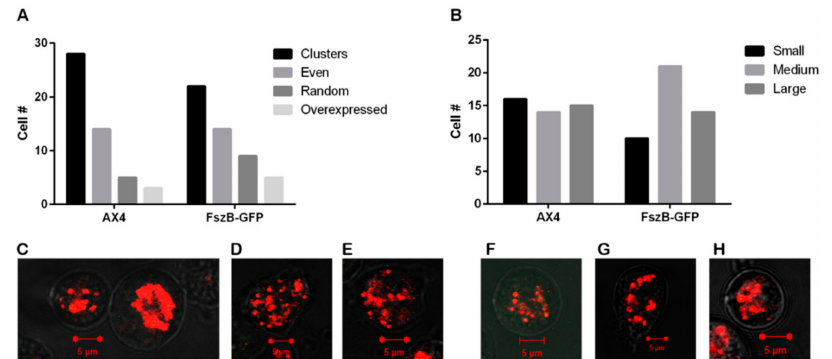
Figure 1. Distribution and size of mitochondria in AX4 and FszB-GFP cells. ( A ) There is no significant di ff erence between the 38% of AX4 cells and 46% of FszB-GFP cells that have evenly or randomly distributed mitochondria (n = 50). ( B ) There is also no statistical di ff erence between cell types when roughly estimating the size of the mitochondria (n = 50 cells). ( C ) Example image of clustered and overexpressed mitochondria. Left cell shows clustered phenotype, right cell shows an overexpressed phenotype. ( D ) Example image of evenly distributed mitochondria and ( E ) example of randomly distributed mitochondria- neither truly aggregated nor fully distributed across the